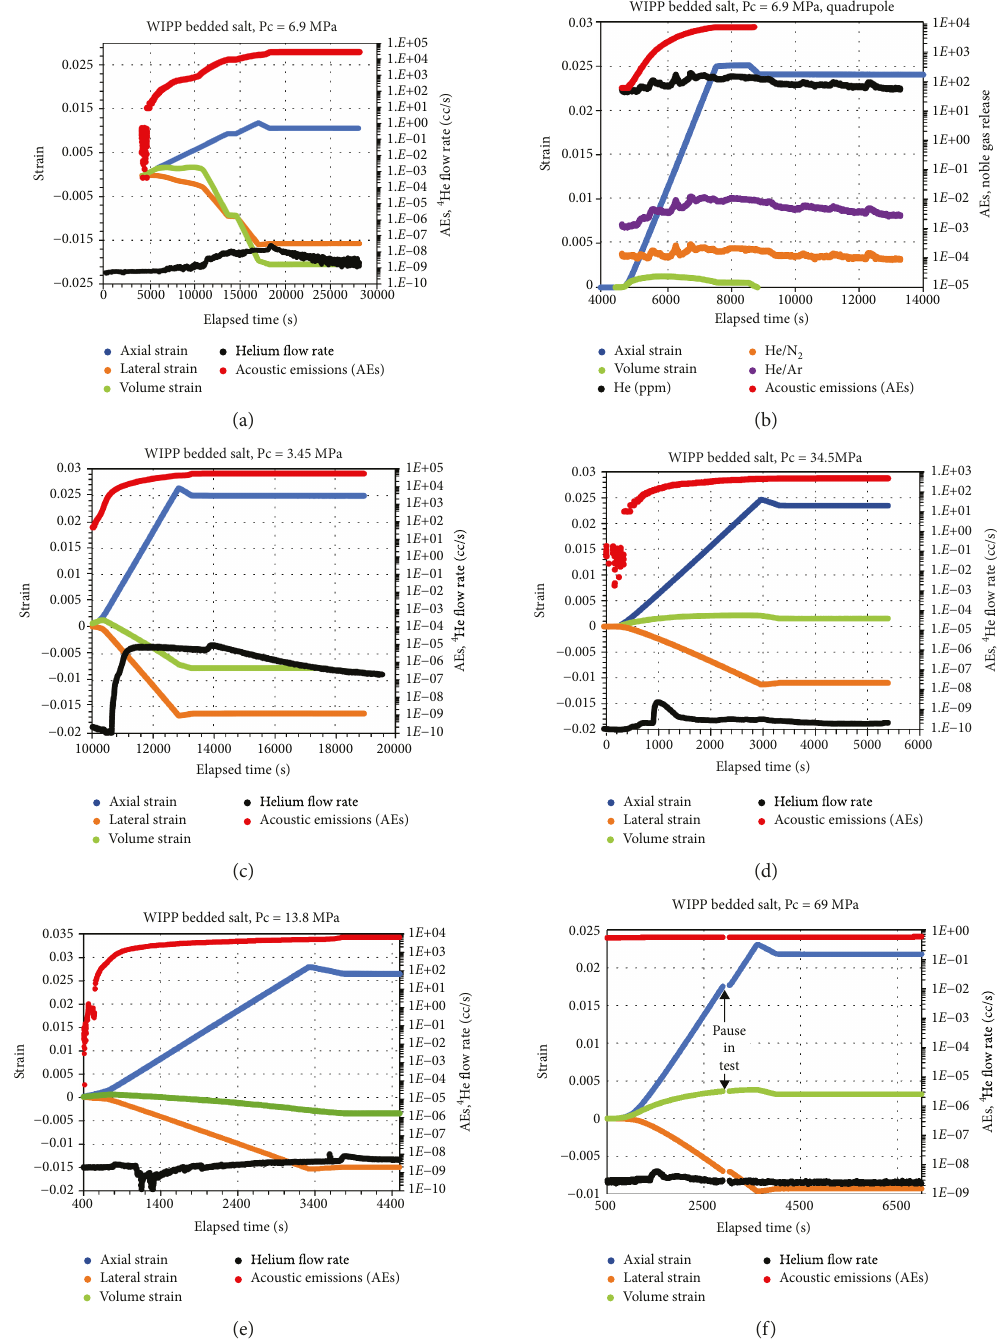
Figure 3: Strains, cumulative acoustic emissions, and gas release (helium fl ow; ccSTP/s) rate or gas concentration (ppm) versus time. (a) Sample QGU16-3_6.0, Pc = 6 9MPa ; (b) sample QGU16-4_8.0, Pc = 6 9MPa ; (c) sample QGU16-3_6.5, Pc = 3 45 MPa ; (d) sample QGU16-3_6.5, Pc = 34 5 MPa ; (e) sample QGU30-1_0.5; Pc = 13 8 ; (f) sample QGU30-1_0.5, Pc = 69 0MPa